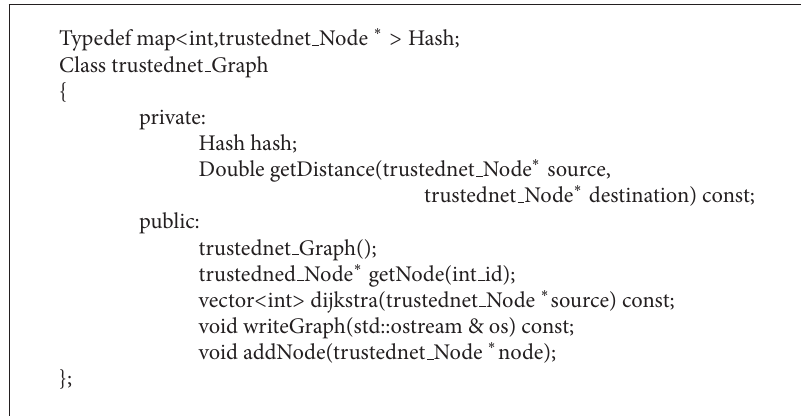
Algorithm 4: Program code of the class trustednet